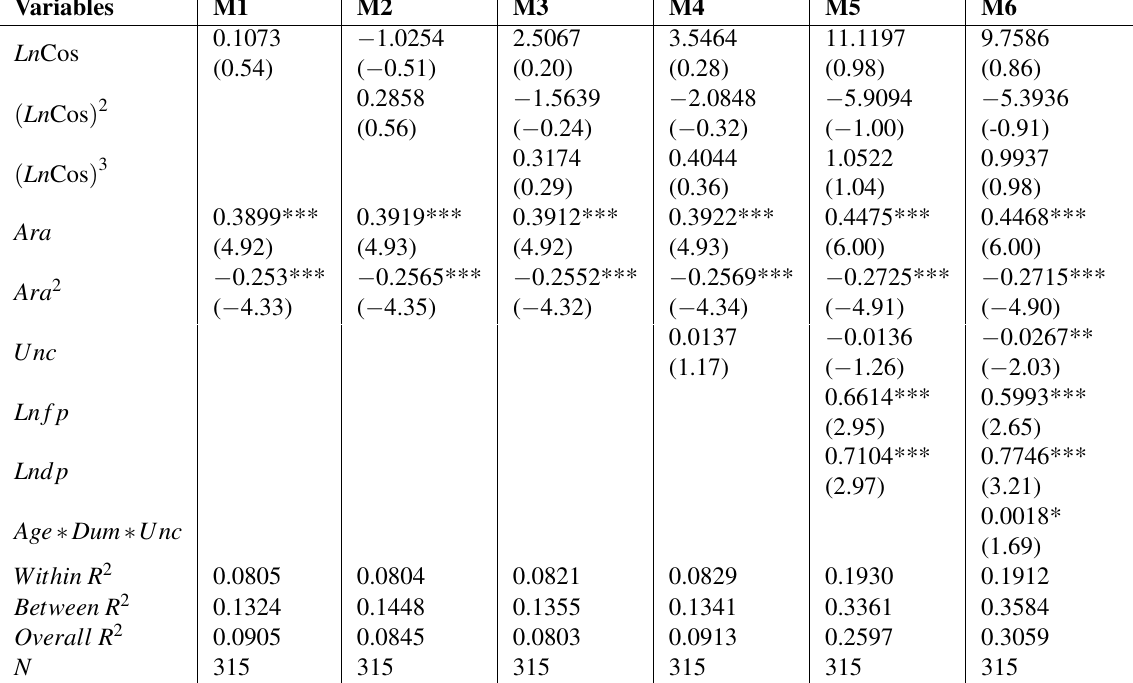
Table 1 Correlation regression analysis of main core